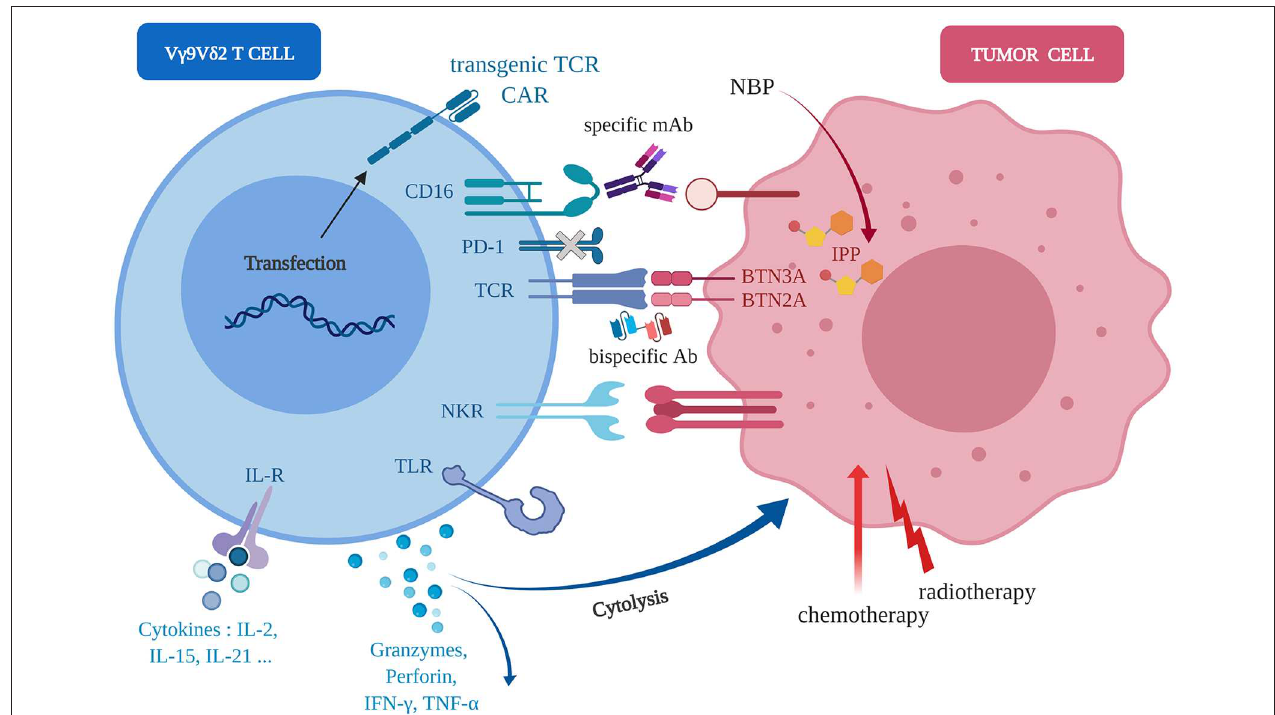
FIGURE 2 | Molecular axes foroptimization(s) of anti-tumor V γ 9V δ 2 immunotherapies. Human V γ 9V δ 2T cells ( left, blue ) can sense human tumor cells ( right, red ) of diverse tissular origins, in independent or cooperative manners, through various molecular pathways implicating wild-type or engineered TCR, NKR, FcR/CD16, TLR, CAR. Following activation, the direct (cytolysis) and indirect (e.g., pro-inflammatory cytokines release) anti-tumor reactivity might be enhanced by either agonist compounds, such as aminobisphosphonates (NBP), standard chemo-radiotherapies or environment factors, such as cytokines (e.g., IL-21).